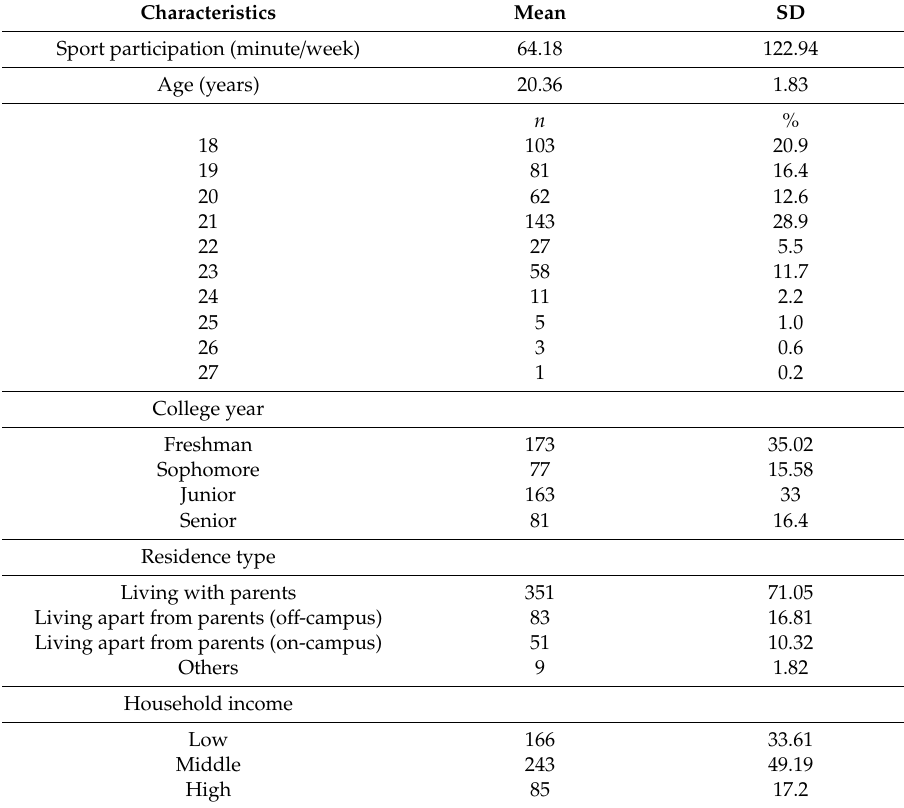
Table 1. Socio-demographic characteristics of participants ( n =